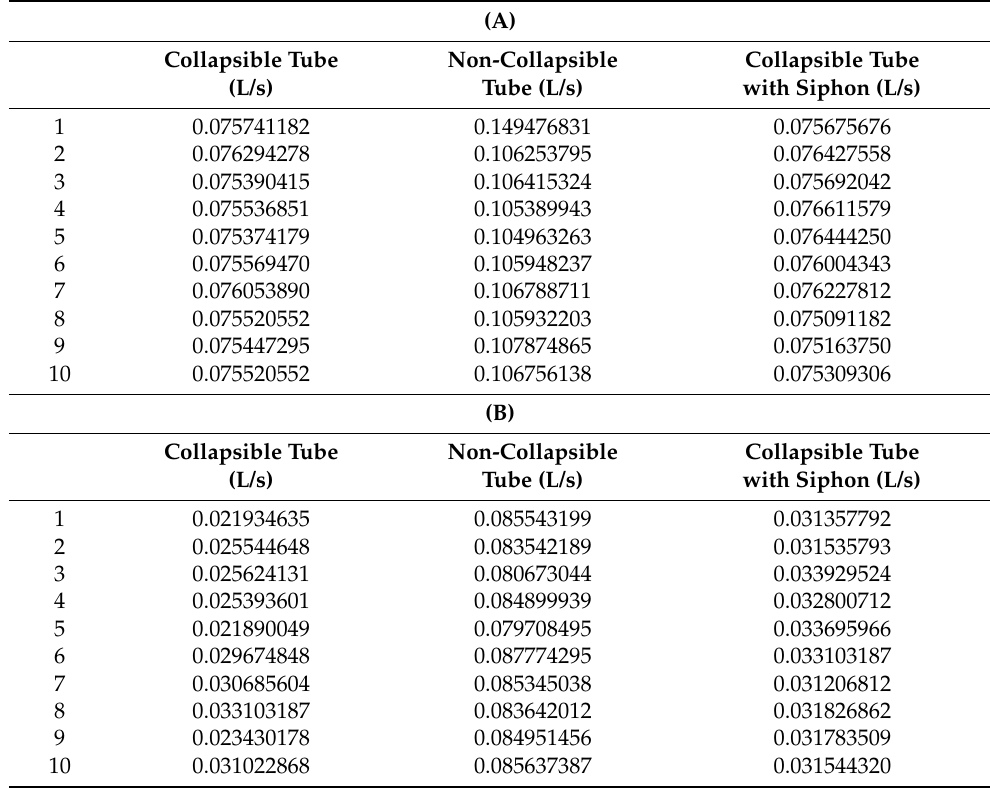
Table 2. ( A ). Flow simulations for an ostrich in a collapsible, non-collapsible, and collapsible tube with a siphon structure. ( B ). Flow simulations for giraffes in a collapsible, non-collapsible, and collapsible tube with a siphon structure.